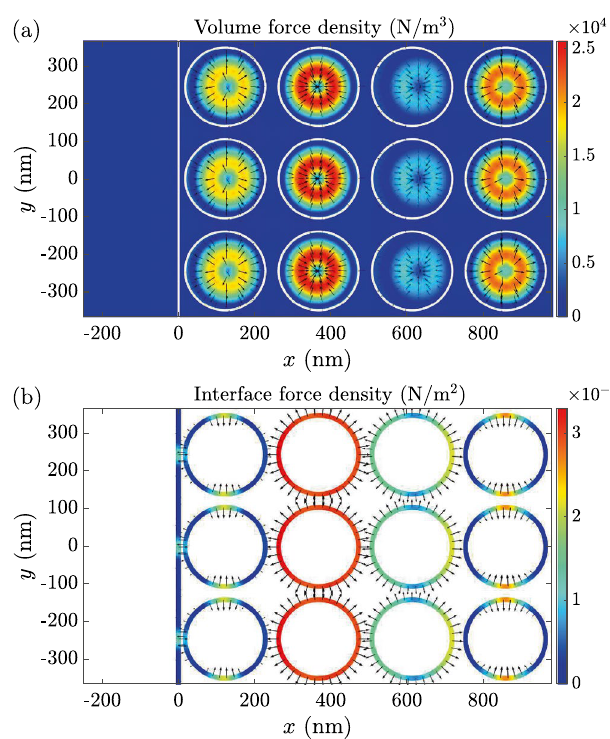
Figure 4. Volume and interface force densities in an inhomogeneous NIM. The instantaneous ( a ) volume and ( b ) interface force densities as a function of position around the entry interface of the NIM structure. The snapshot is taken at the instance of time in which the energy density maximum of the Gaussian light pulse incident from the left is at x = 0 . The linearly scaled color indicates the magnitude, and the logarithmically scaled arrows indicate the direction of the force densities. White solid lines depict material